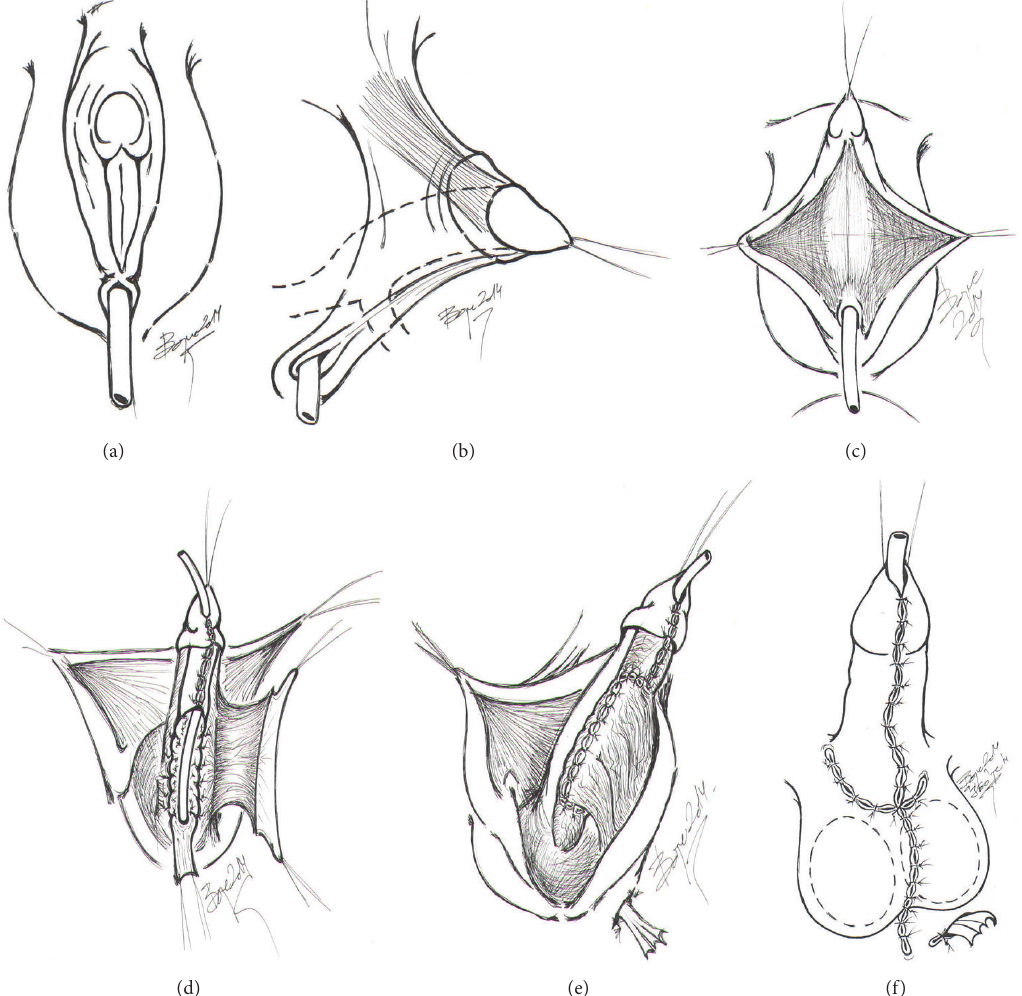
Figure 1: Schematic presentation of clitoral anatomy in metoidioplasty. (a) Ventral aspect of hormonally enlarged clitoris; labia majora appear as scrotums. (b) Clitoral bodies are curved due to dorsal ligamentous support and short urethral plate. (c) Urethral plate is wide and adherent, with visible demarcation to labia minora. (d) Urethroplasty—buccal mucosa graft, previously quilted, combined with well vascularized labia minora flap. (e) Flap is joined with buccal mucosa graft to create neourethra. (f) Final appearance of the neophallus.